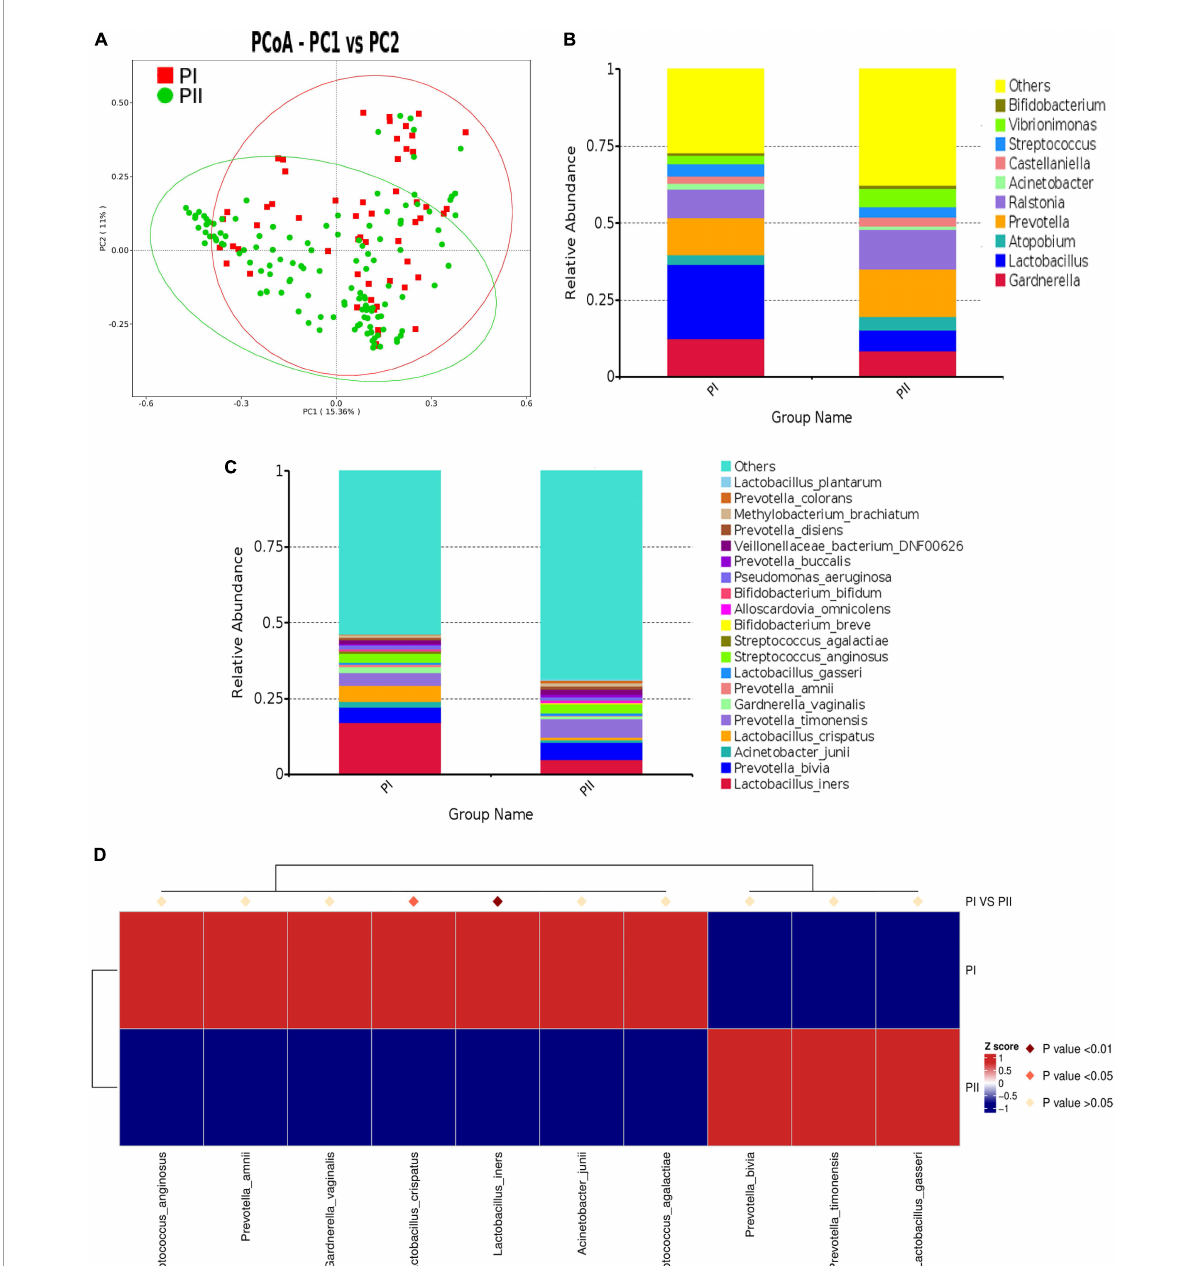
FIGURE4 Comparison of microbiota composition between PI and PII Group. (A) PCoA dissimilarity between PI and PII. (B) Histogram of the relative abundance of vaginal microbiota with top 10 genus in PI and PII groups. (C) Histogram of the relative abundance of vaginal microbiota with top 20 species in PI and PII groups. (D) Heat map of the vaginal microbiota in PI and PII groups at species level. PI, postpartum women with relatively good pelvic floor function; PII, postpartum women with relatively poor pelvic floor